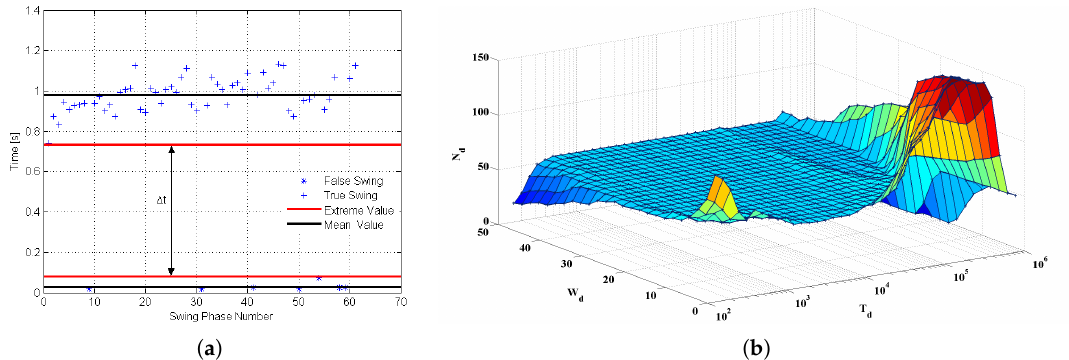
Figure 7. Gait phase detection by the k-mean clustering algorithm. ( a ) Swing phases detection; ( b ) using different window sizes W d and detection thresholds T d to detect step numbers.